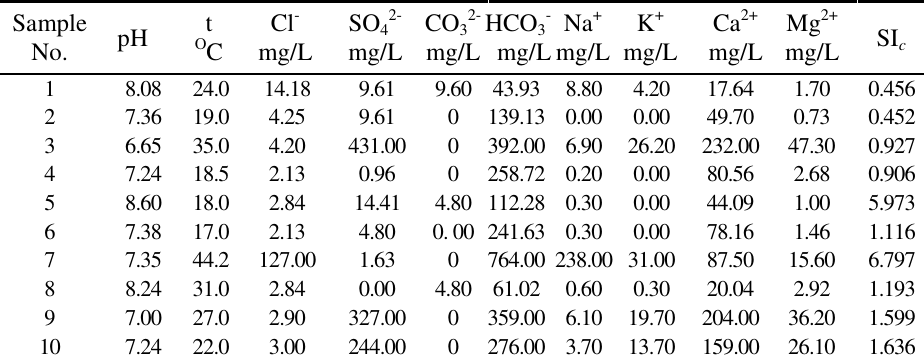
Table 1. Analysis results of water